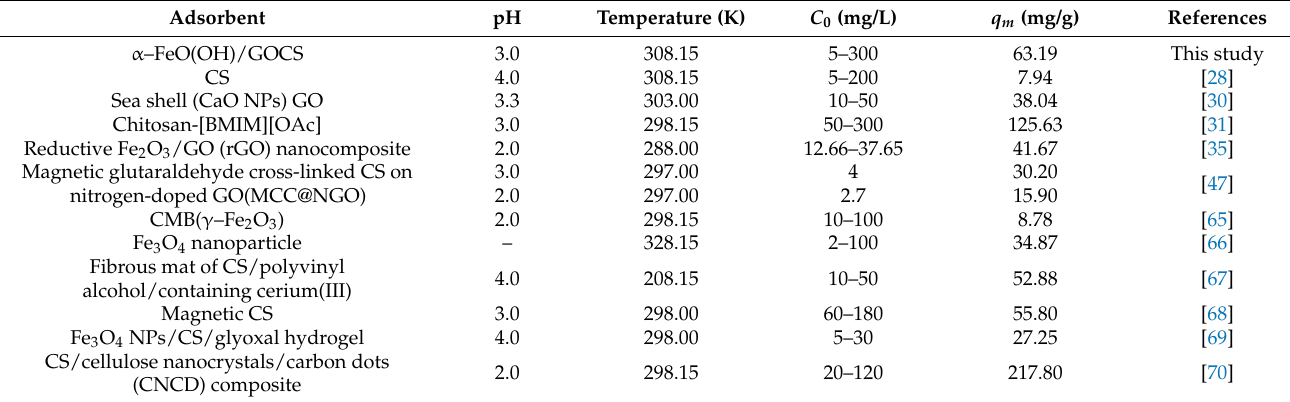
Table 5. Adsorption capacity of other adsorbents for